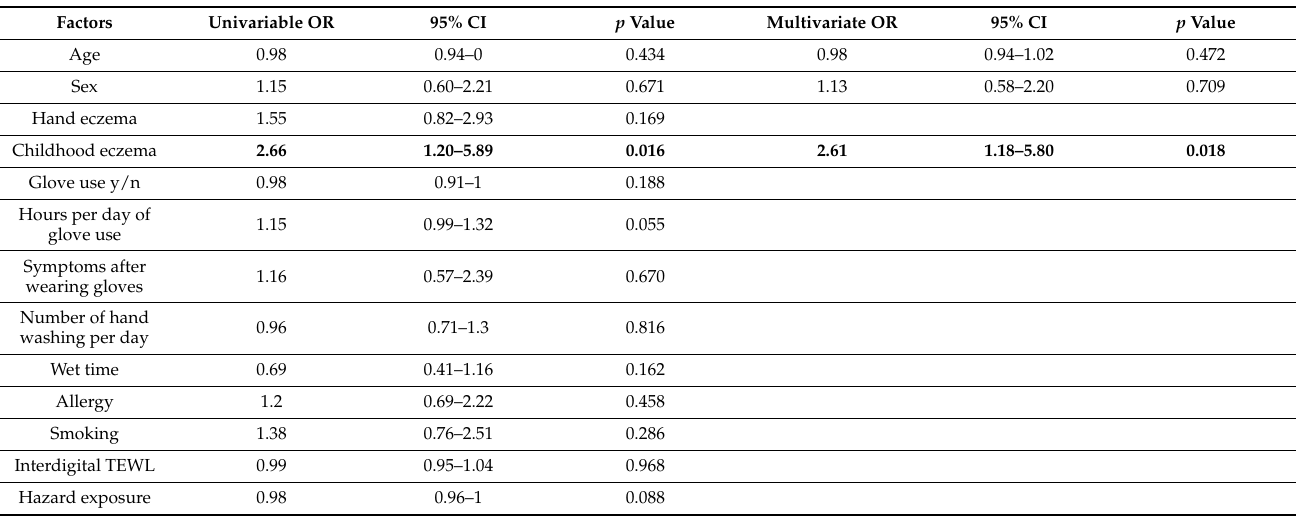
Table 2. Factors associated with HE investigated using univariate and multivariate logistic regression analysis. Associations are reported as odds ratios (ORs) and 95% confidence interval (CI). Statistically significant data are highlighted in